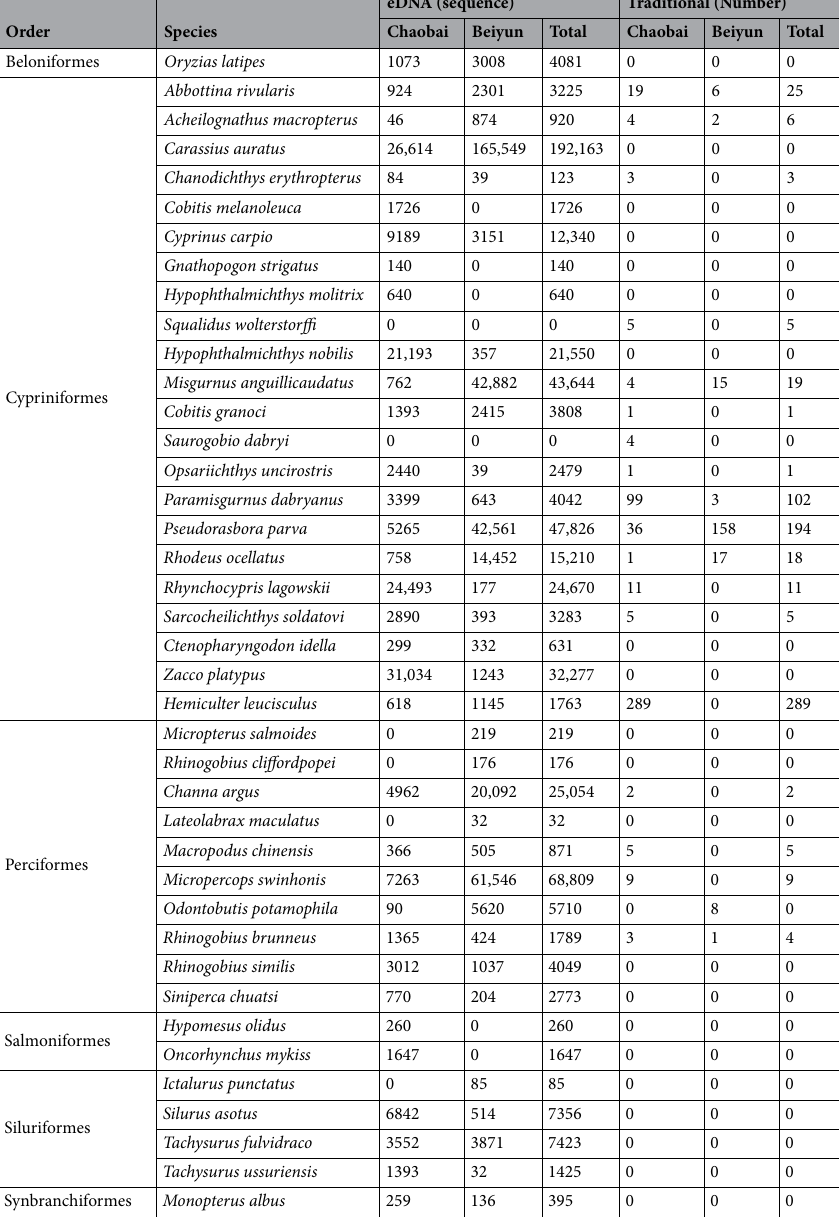
Table 1. Sequence numbers of fish detected by eDNA and caught by ground cages at 10 sites in